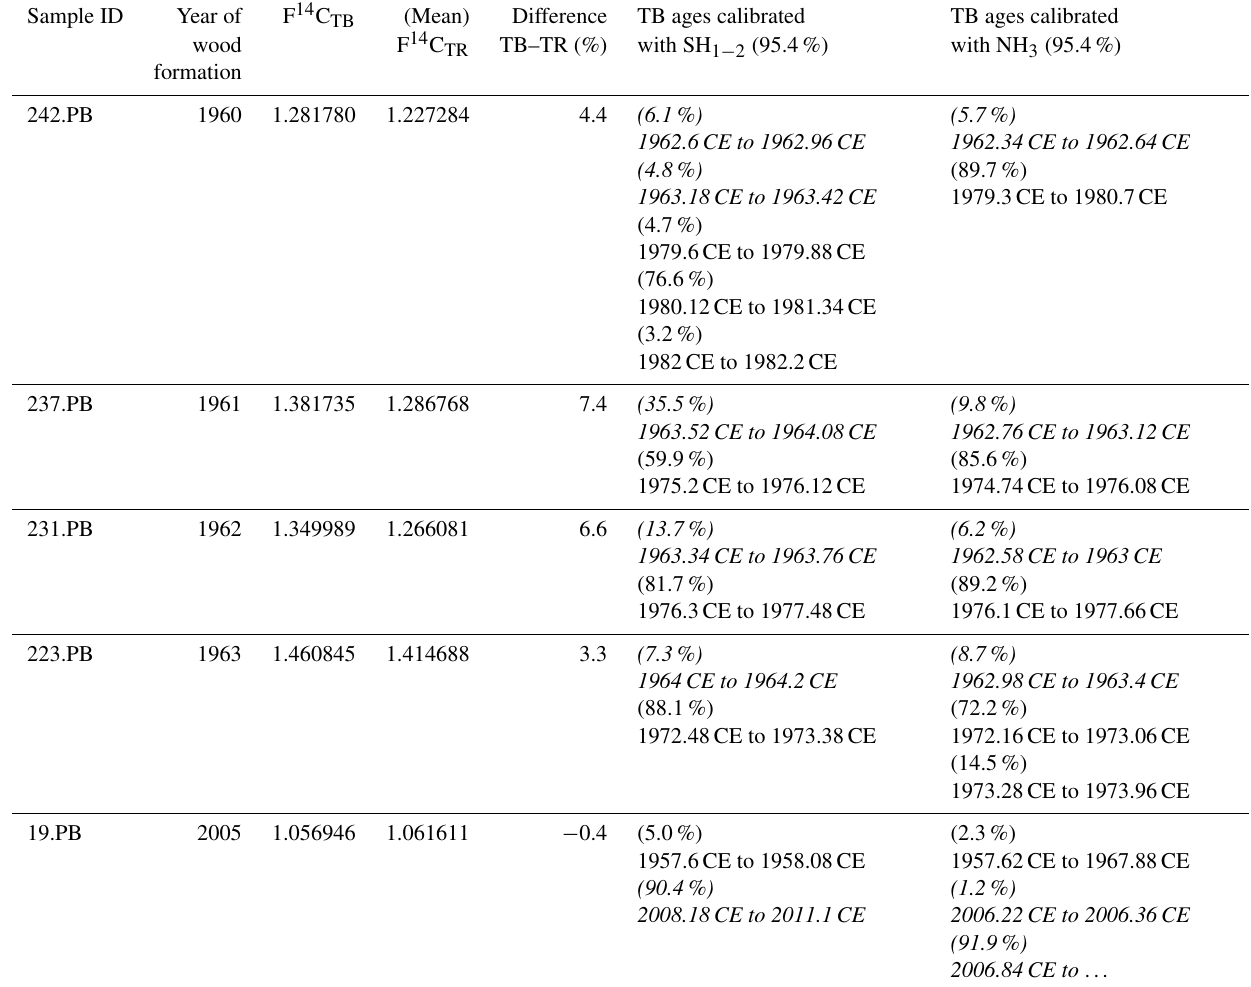
Table 2. Comparison of the F 14 C values of terminal parenchyma bands (TPBs) and the corresponding tree ring (TR). In case of multiple measurements per ring, the mean value was taken for comparison. Considering the youngest possible calibrated age, most TPBs are signifi- cantly younger than the corresponding tree ring. The end of growth is assumed to be at the end of September, i.e., at 0.75 of each year. Please note that the calibration always yields age ranges on the rising side of the bomb peak as well as on the falling part. For years ≤ 1964 only the rising side and for years ≥ 1965 only the falling side were considered for consistency. Italic calibrated ages are viable, and others are only theoretical and given for sake of